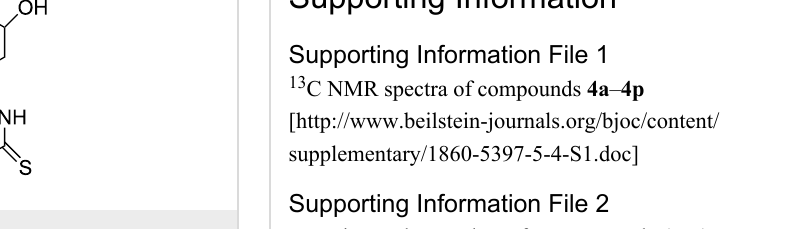
Figure 1: Monastrol ( 4n